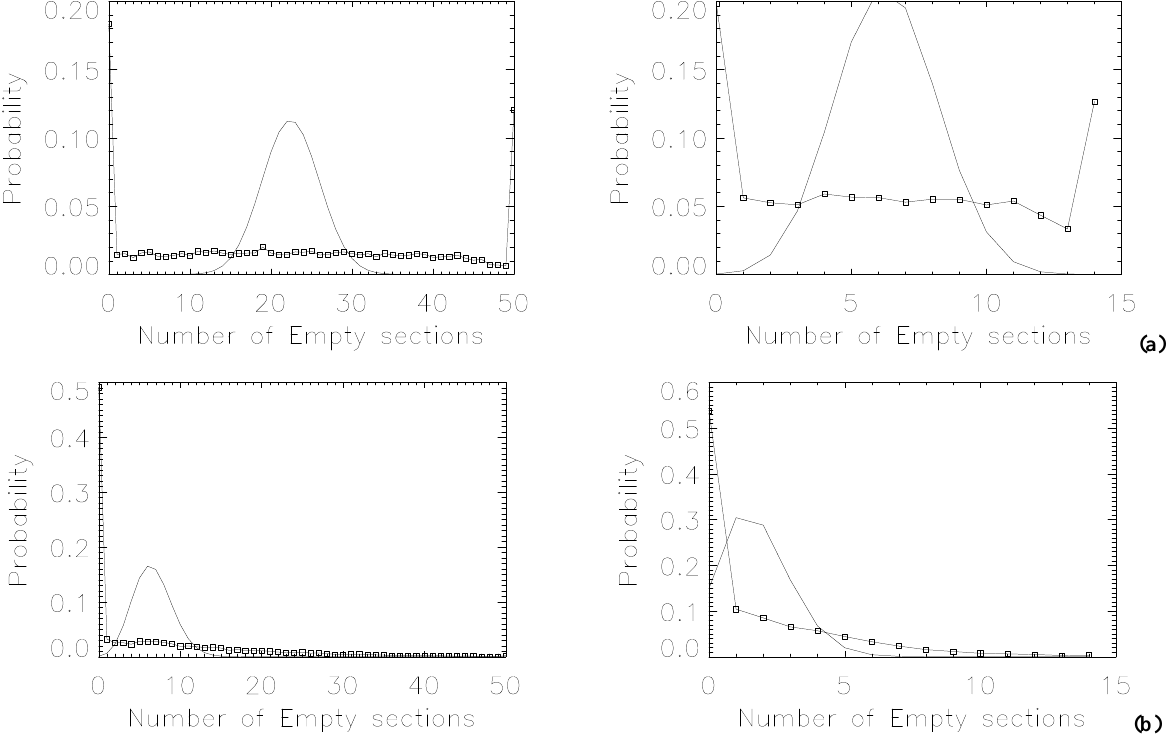
Fig. 2. The probability mass function (squares) for the number of uncontaminated 1-km sections (left-hand panels) and 3.5 sections (right- hand panels) in a 50-km interval for a cloud fraction of (a) 53% with mean hole length of 35.3km, and (b) 83% with mean hole length 13.4km. Again, also shown is the binomial distribution that would apply if adjacent sections were assumed